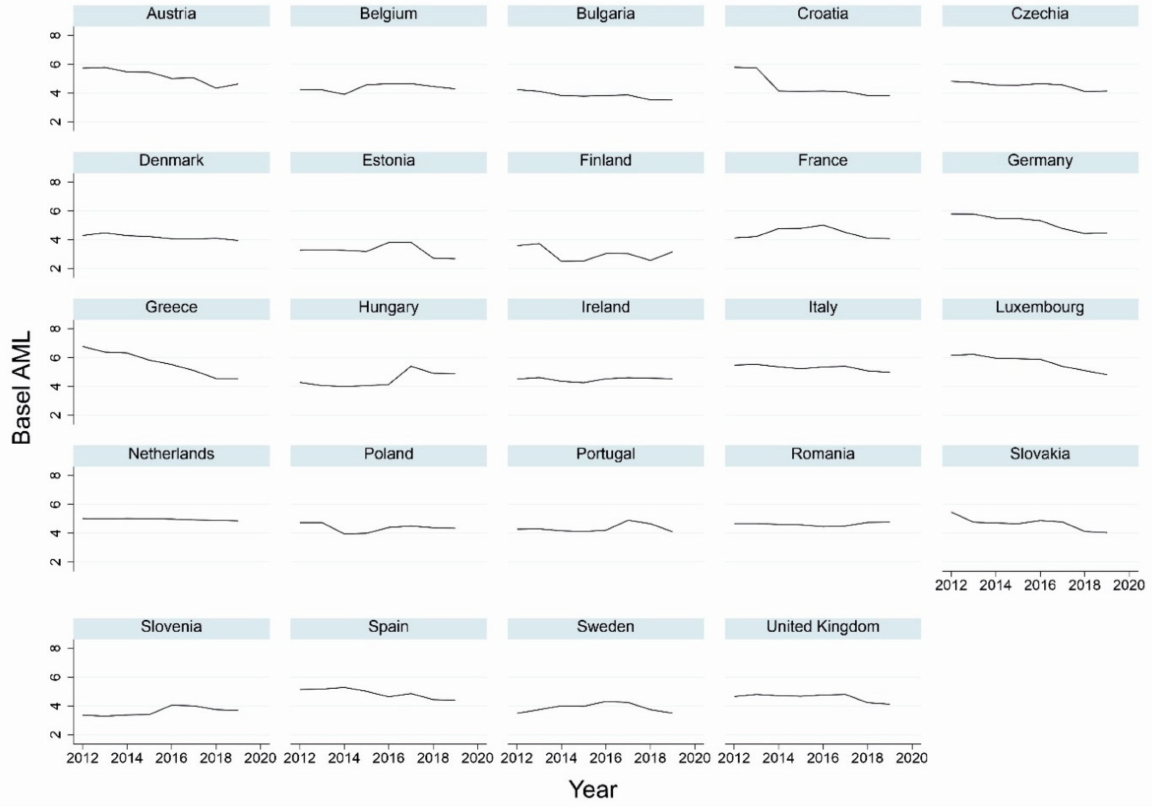
Figure 2. Development of the Basel AML index in 24 EU countries during the observed period of 2012–2019, except Cyprus, Malta, Lithuania and Latvia due to missing data. Source: Compiled by the